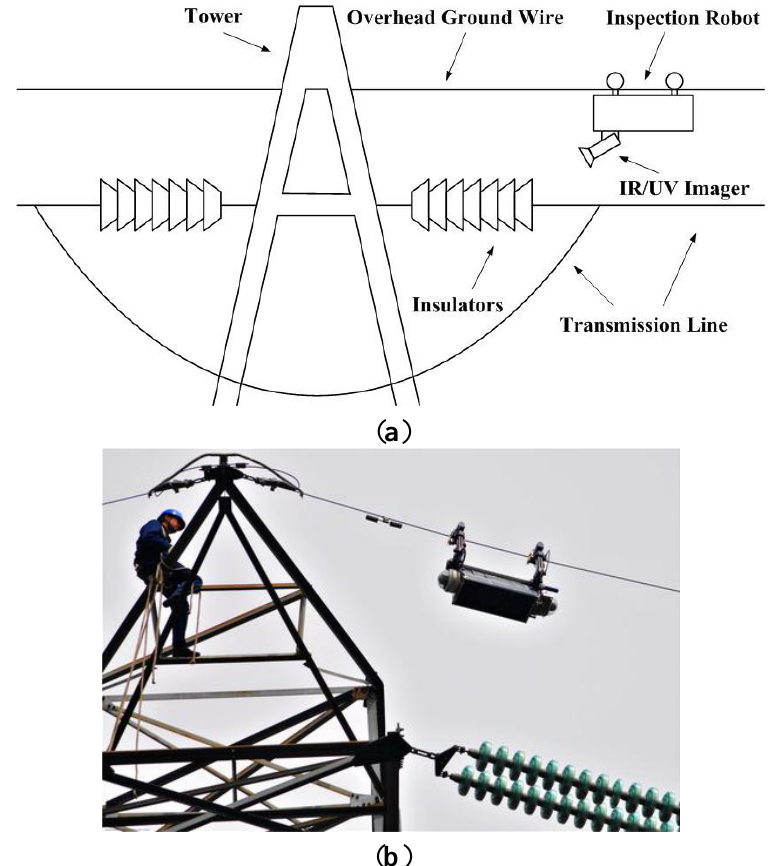
Figure 1. Inspection robot equipped with infrared (IR) and ultraviolet (UV)